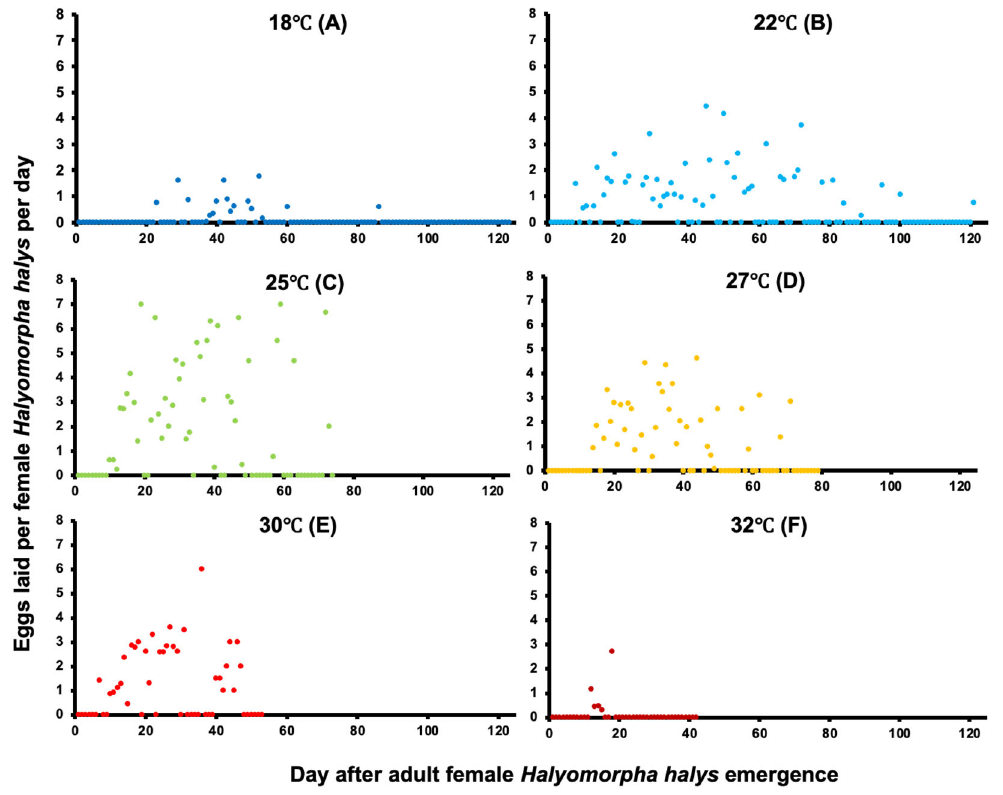
Figure 2. Mean eggs per female per day (EFD) of H. halys in Oregon at six constant temperatures: 18 18 ◦ C ( A ; dark blue), 22 ◦ C ( B ; light blue), 25 ◦ C ( C ; green), 27 ◦ C ( D ; yellow), 30 ◦ C ( E ; red) and 32 ◦ C °C ( A ; dark blue), 22 °C ( B ; light blue), 25 °C ( C ; green), 27 °C ( D ; yellow), 30 °C ( E ; red) and 32 °C ( F ; dark red). ( F ; dark